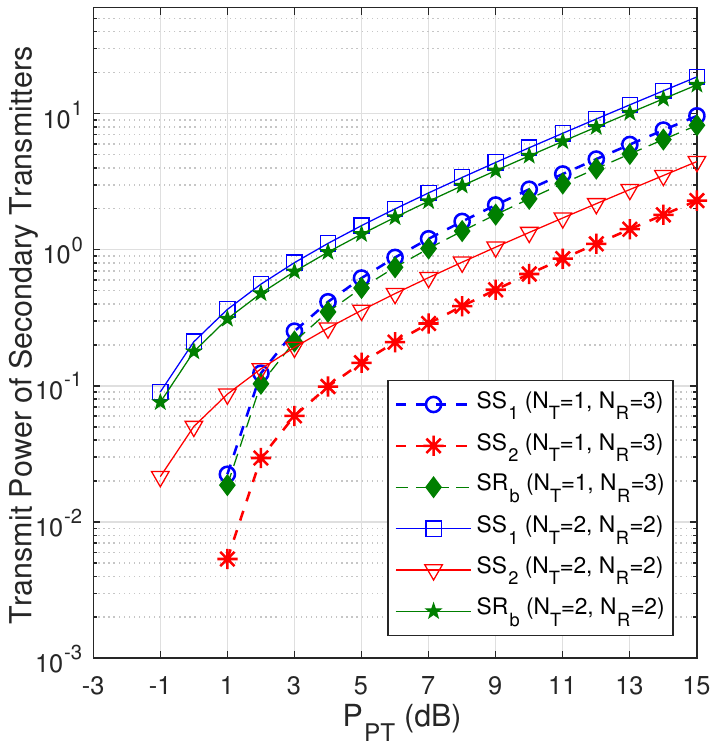
Figure 3. Transmit power of the secondary transmitters as a function of P PT (dB) when x R =